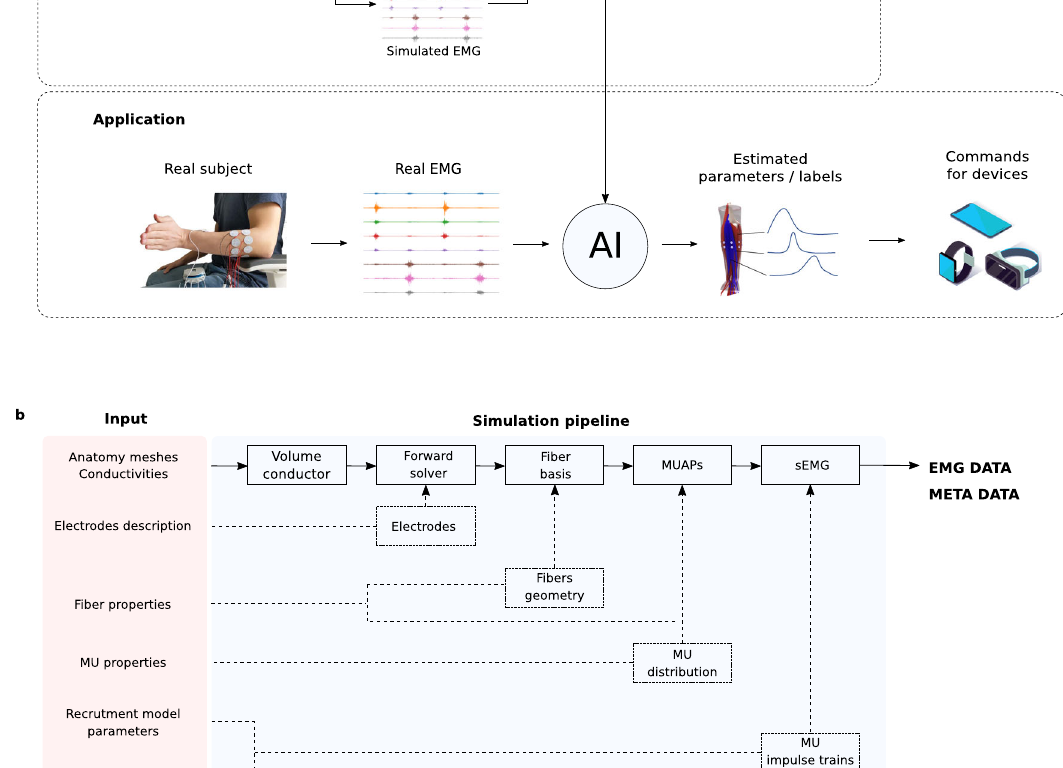
Fig.1|Simulationpipeline.a GeneralstrategyofusingMyoelectricDigitalTwinto train an arti fi cial intelligence (AI), that then can be used to process real surface electromyography (sEMG) signals in real-world applications. b Schematic repre- sentation of the software ’ s input, main elements of the simulation pipeline and output. User can de fi ne a largeset of simulation parametersdescribing anatomical and physiological properties of the tissues, geometry and montage of electrodes,